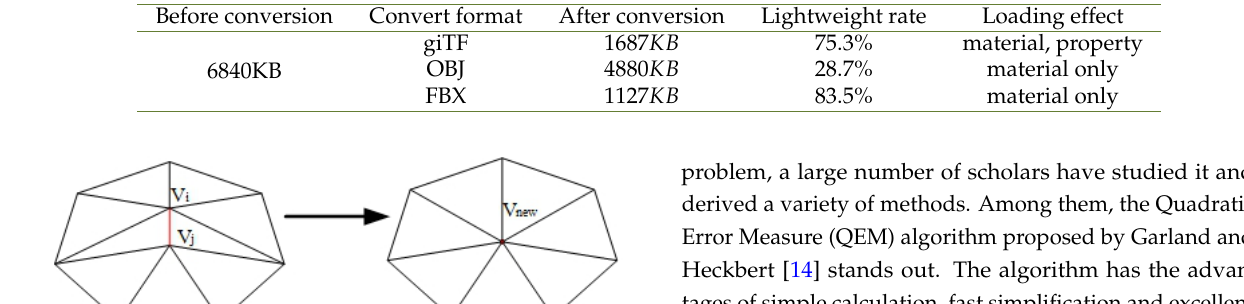
Table 1. The application effect of different data formats